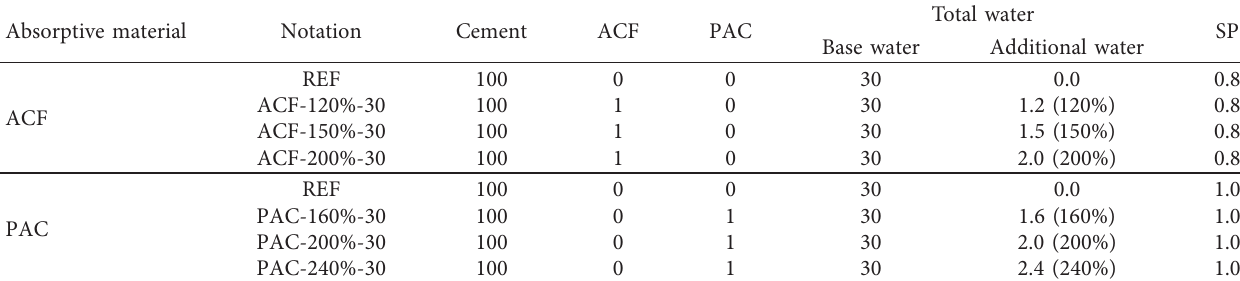
Table 2: Mixing proportions for part 1 (relative mass).